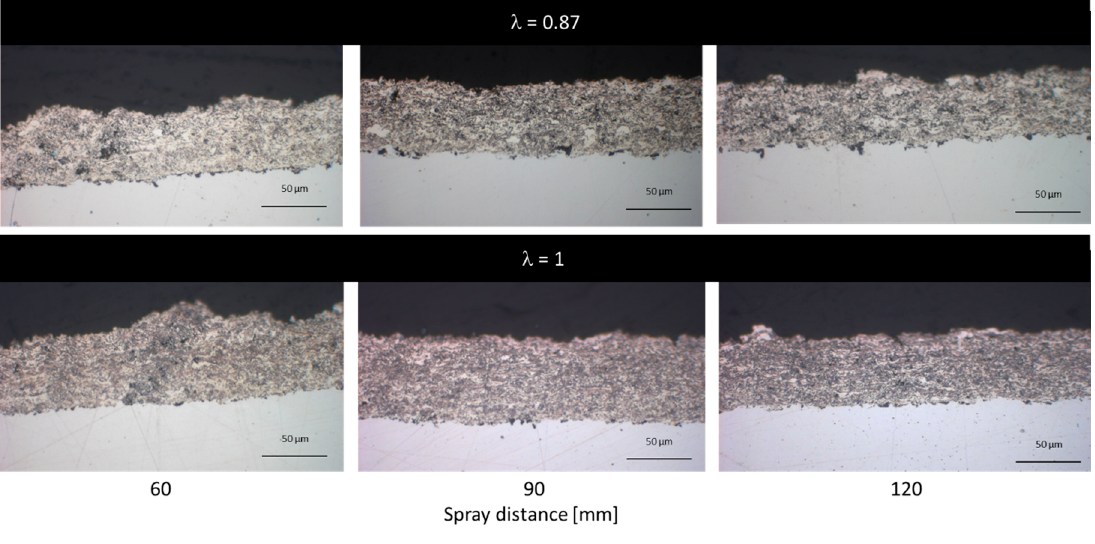
Figure 4. Optical microscope cross-section images of NiCr coatings sprayed with two different λ (0.87 and 1) and with three different spray distances (60, 90, and 120 mm).